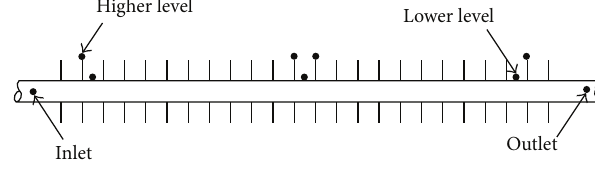
Figure 2: Installation of the thermocouples on the